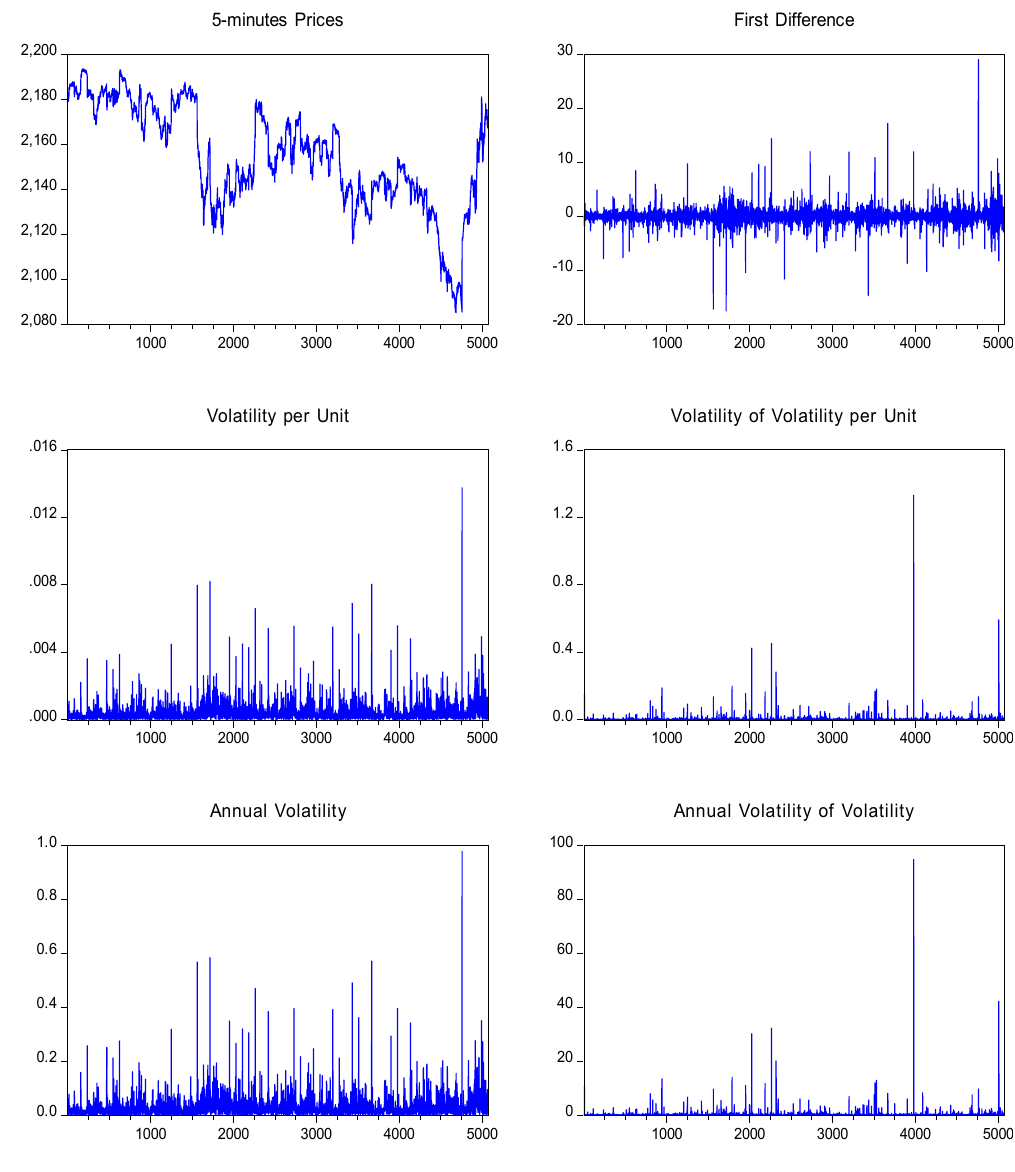
Figure 2. Plot of the S&P 500 5-min sample.